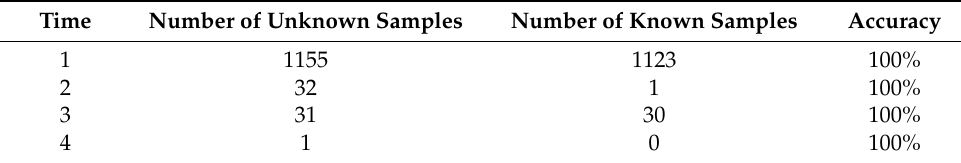
Table 1. Assessment process of stacked-GRU.